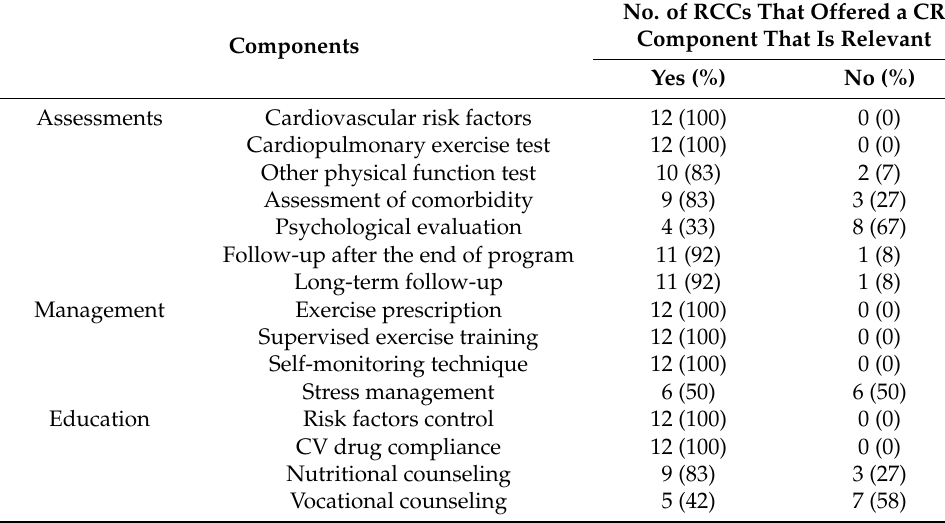
Table 4. Offered Cardiac Rehabilitation Components in 12